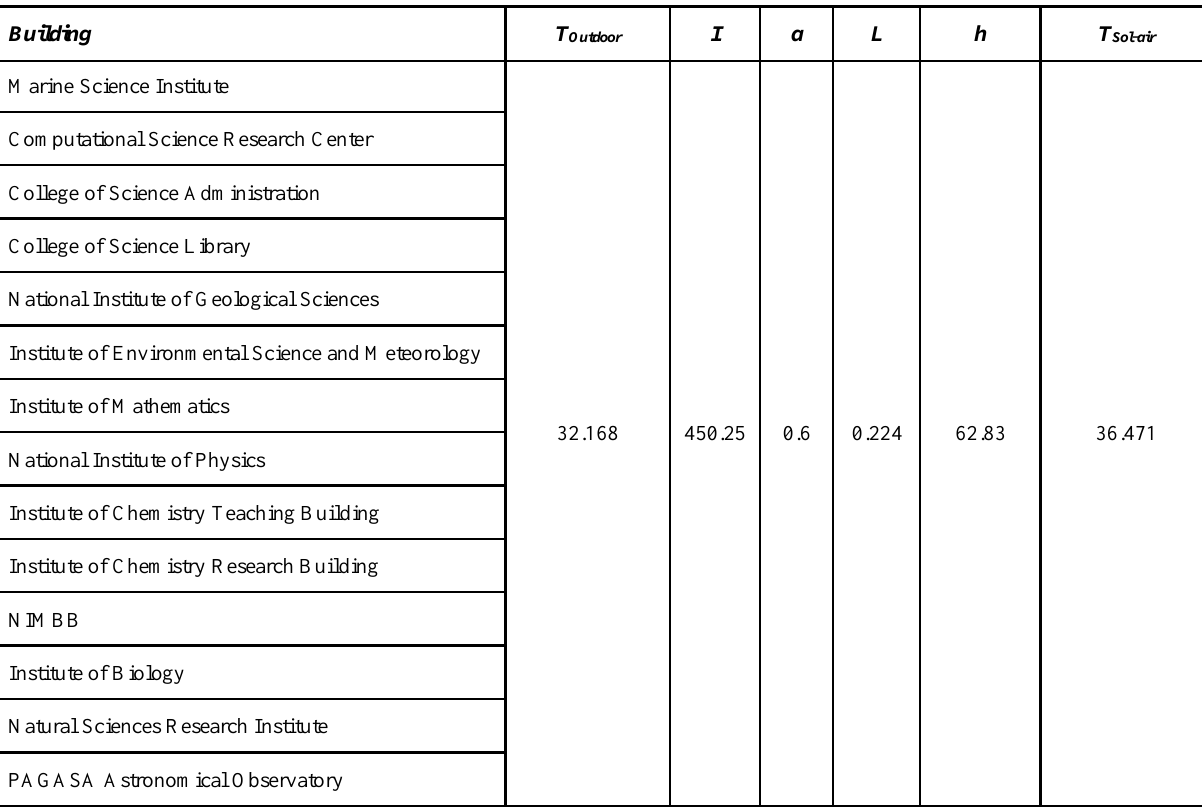
Table 2. Solar air temperature calculation (see section 2.2.2 for information on the variables).